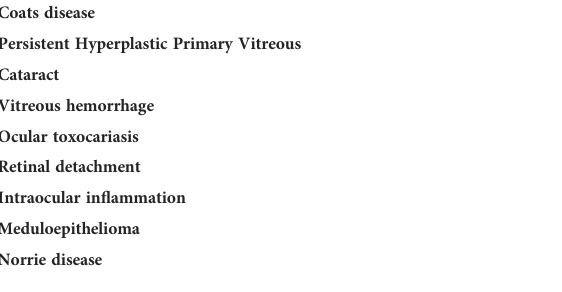
TABLE 1 Differential diagnosis of